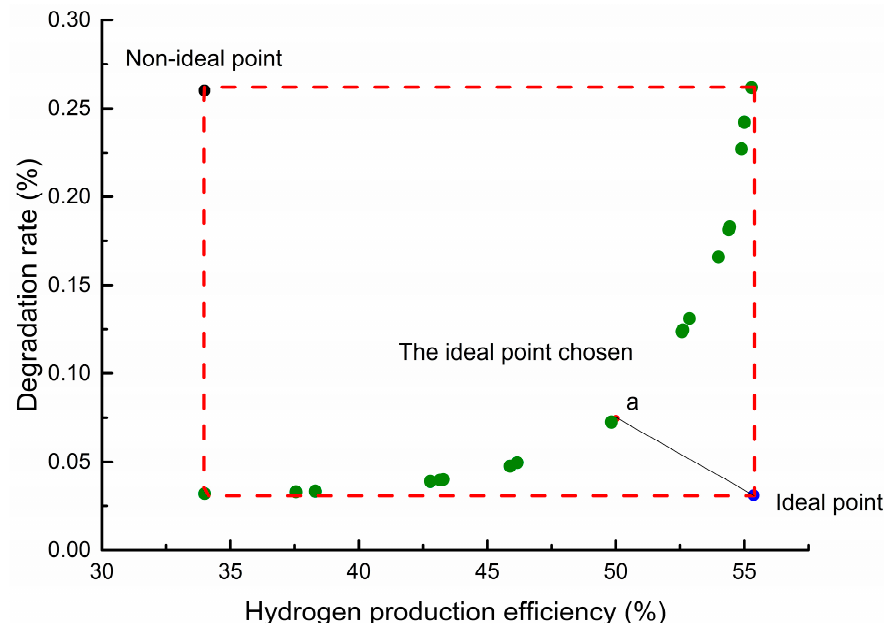
Figure 8. Pareto solution set at degradation for 1200 h.